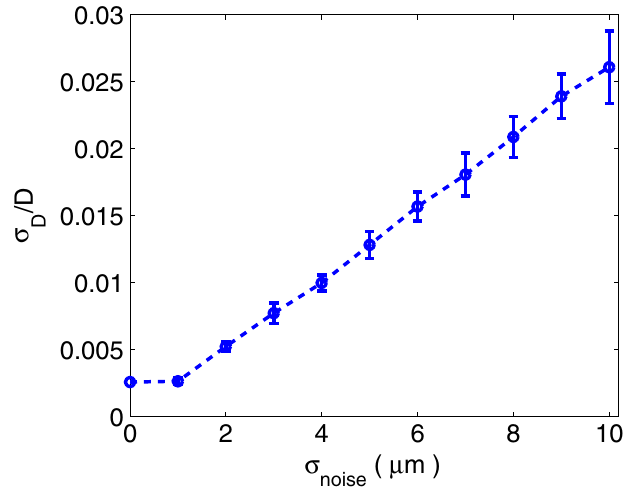
FIG. 4. (Color) Estimation of errors of ICA methods with vari- ous random noise levels. The estimation at each noise level (cid:15) of BPMs is made by repeating the ICA analysis of the vertical dispersion 20 times with Gaussian random noise added to each